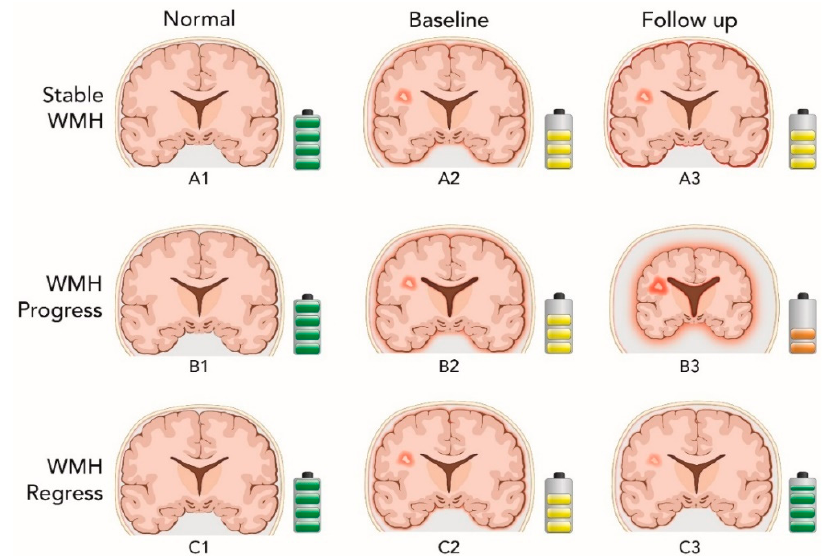
Figure 2. Descriptive figure showing the dynamic nature of the white matter hyperintensity changes over time and the associated change in brain volume and cognitive performance. The coronal image cartoon represents the brain and ventricle size (scale of change exaggerated for emphasis), while the battery represents memory performance (improved memory corresponding to more battery capacity and green). The first column represents a normal brain with no WMH and normal memory, the second and third columns the baseline and two-year follow up showing changes over the course of the study. The upper row represents WMH stability. Brain volume and memory remained stable in the follow up visit as shown in A2 and A3. The middle row illustrates the case of progression of WMH over time. In B3, the WMH region enlarges, brain volume decreases along with ventricular increases and memory declines compared to B2. Finally, the lower row represents cases of WMH regression over time. In C3, the WMH lesion volume shrinks, brain volume is maintained, and memory is improved when compared to C2.